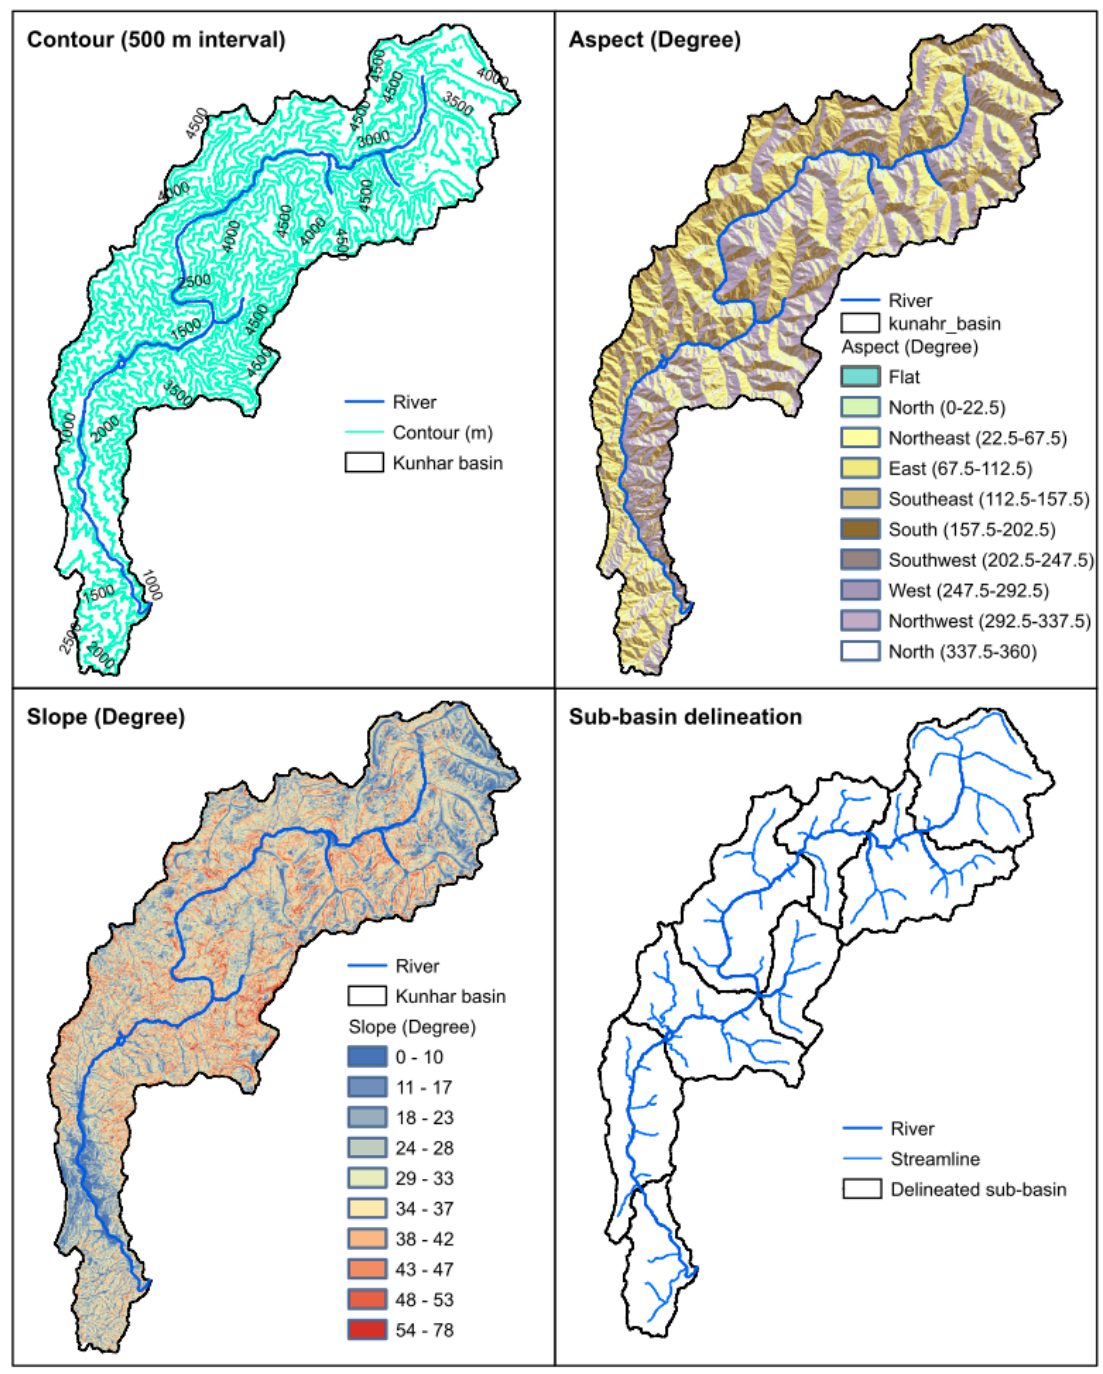
Figure 2. Topographical features and streamline delineation of the Kunhar River basin.